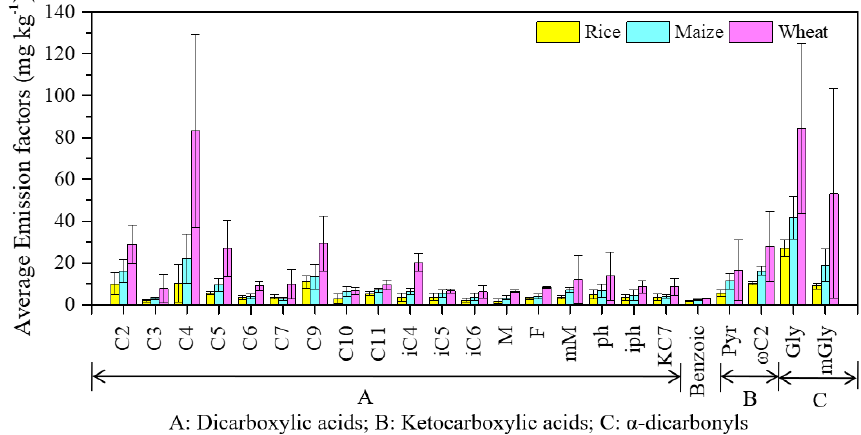
Figure 1. Average emission factors of dicarboxylic acids and related compounds in fresh PM 2 . 5 aerosols from biomass burning.